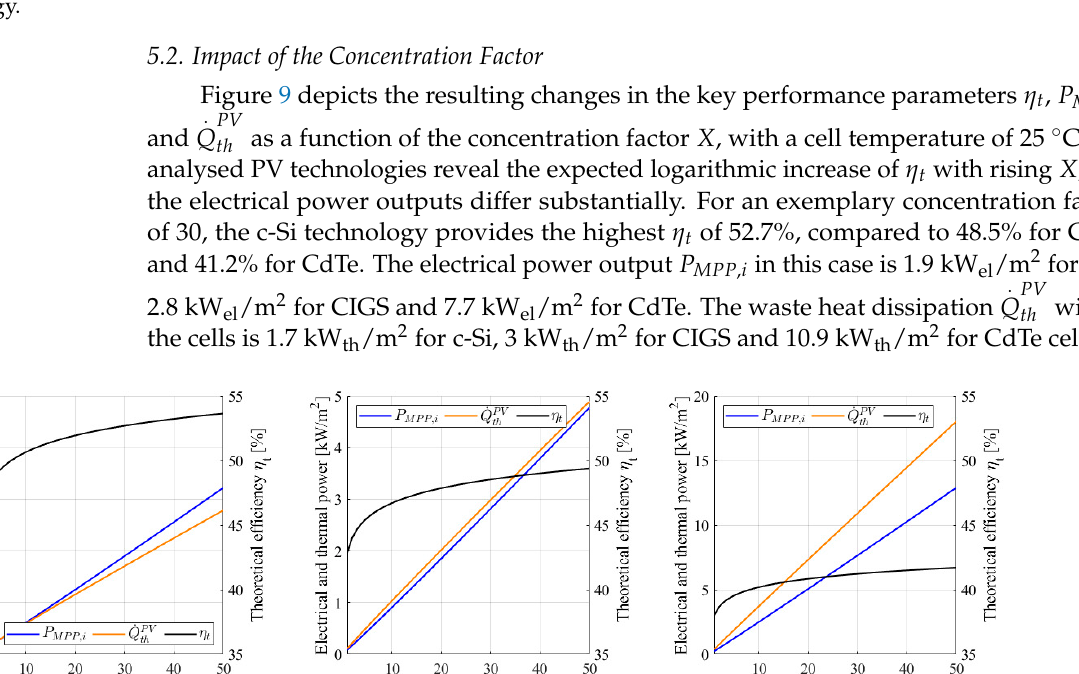
Figure 8. Key parameters of Spectral Splitting depending on cell temperature for c ‐ Si ( left ), CIGS ( middle ) and CdTe ( right ) PV technology.